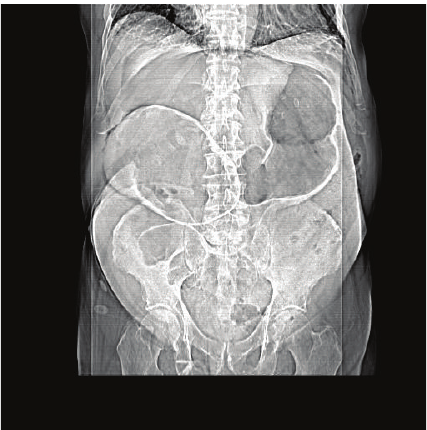
Figure 1: Abdominal X-ray revealing distended large bowel with a collapsed small bowel.